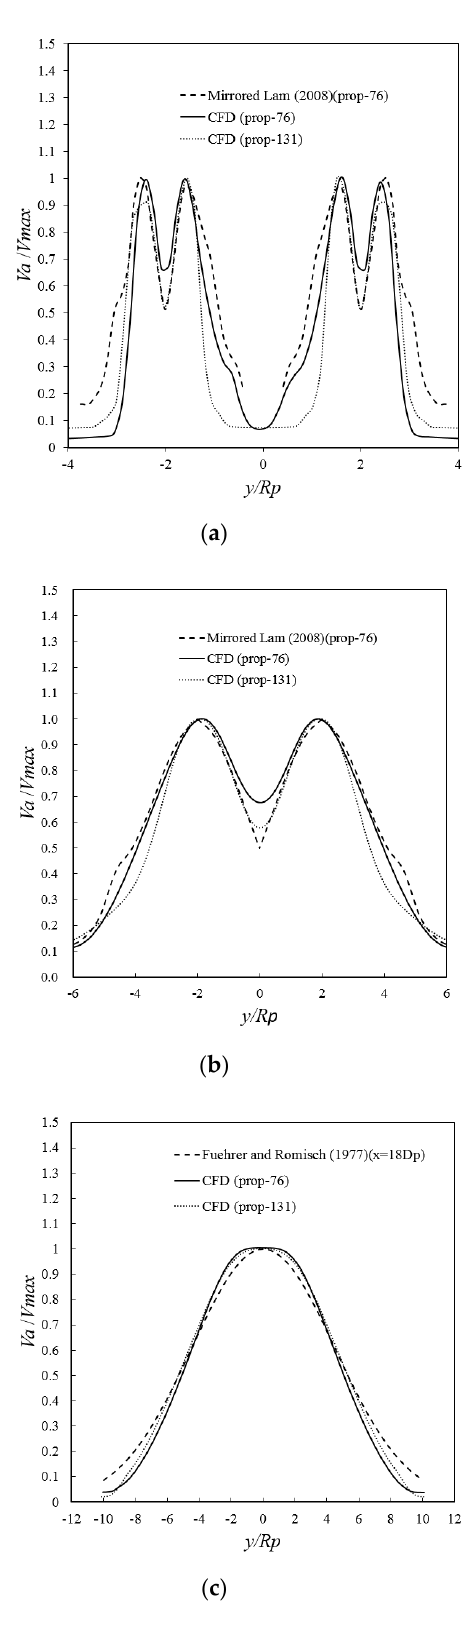
Figure 10. Axial velocity distributions within different zones: ( a ) 1.6 D p within ZFE-TP-4P; ( b ) 8 D p within ZFE-TP-2P; ( c ) 18 D p within zone of established flow.